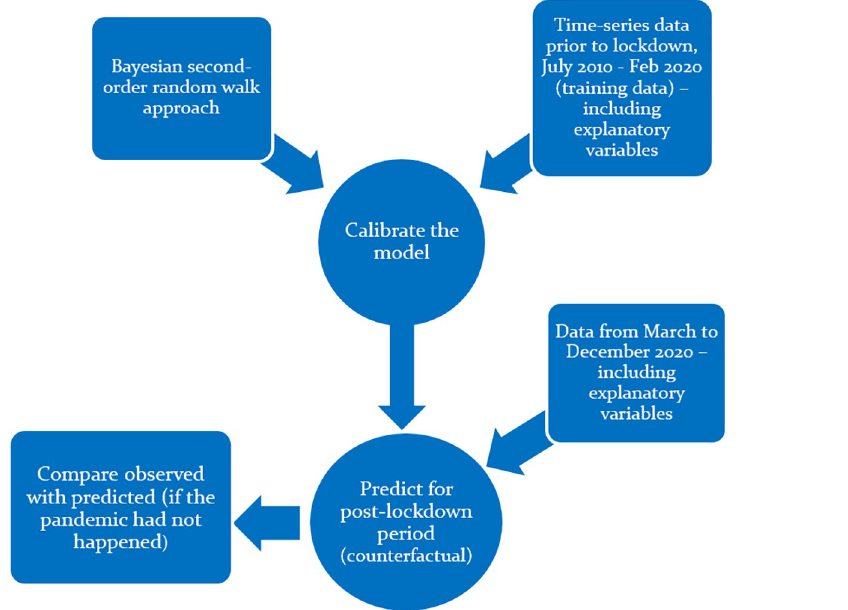
Fig 3. Schematic view of the methodological approach.